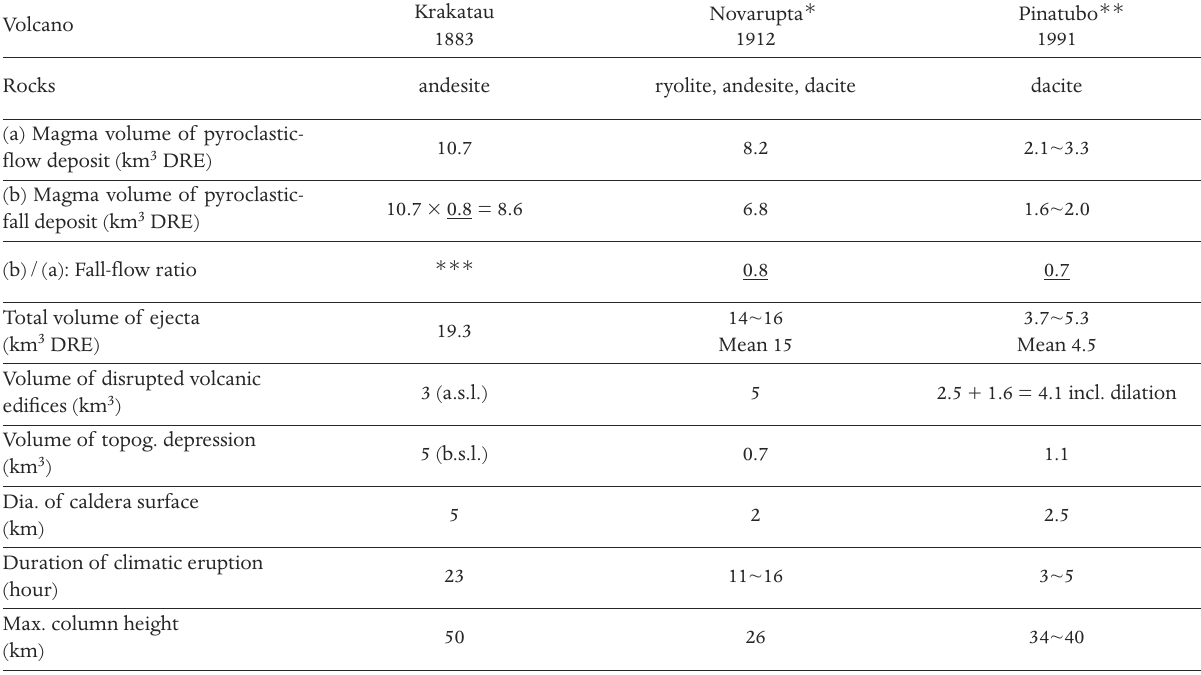
Table 3. Comparison among the three caldera-forming eruptions. ( ∗ ): after Hildreth [1983] and Fierstein and Hidreth [1992]; ( ∗∗ ): after Pal- adio-Melosantos et al. [1996] and Scott et al. [1996]; ( ∗∗∗ ): (b)/(a) is assumed to be